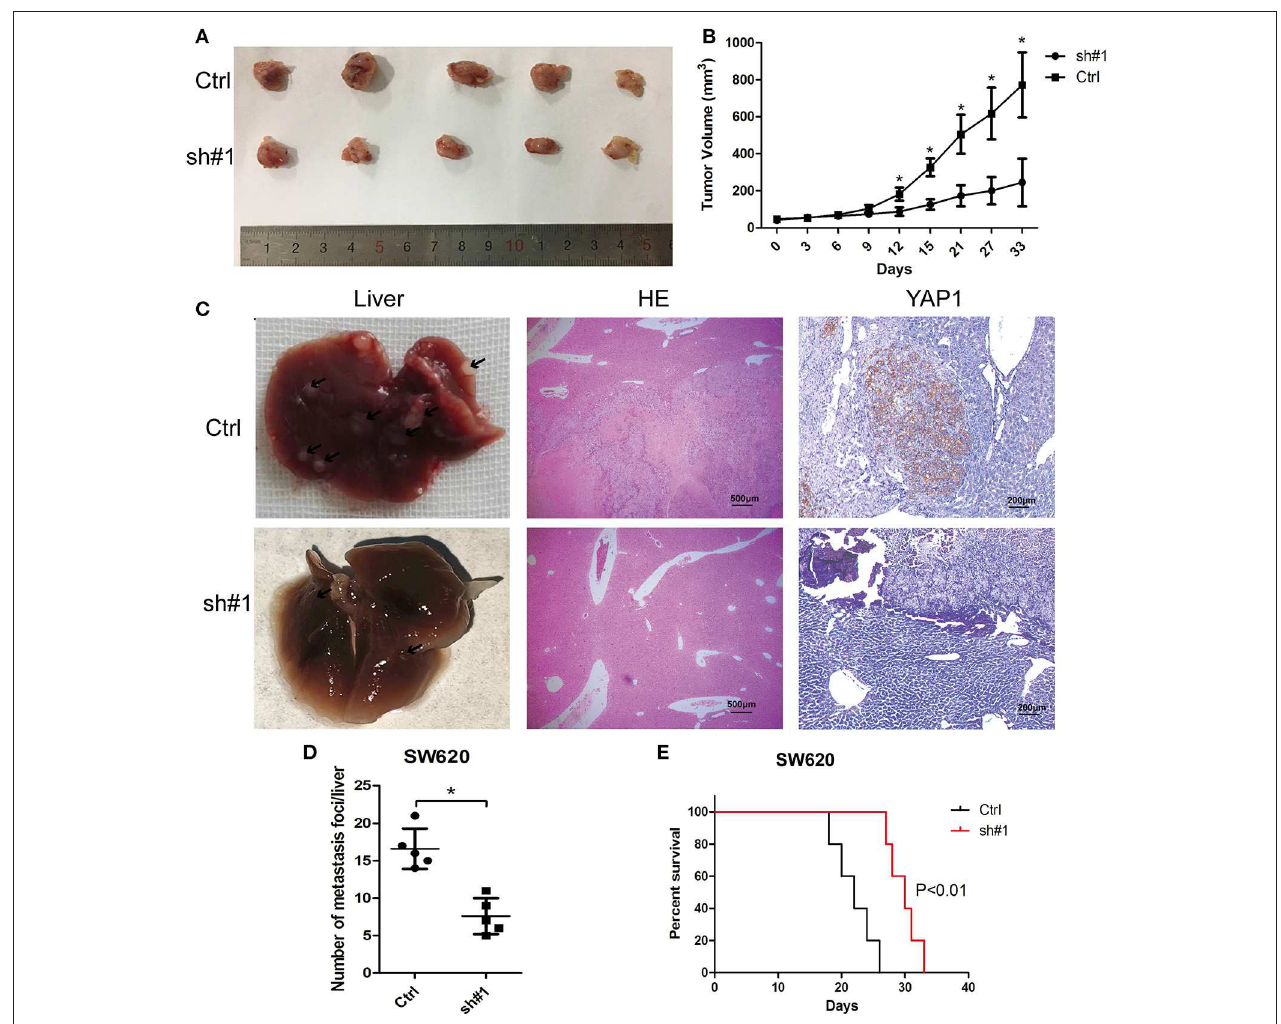
FIGURE 4 | MIR4435-2HG silencing inhibited colorectal cancer (CRC) growth and metastasis in vivo . (A,B) SW620 cells where MIR4435-2HG was stably knocked down of were subcutaneously transplanted into BALB/c nude mice in a xenograft model ( n = 5 mice per group). Two-tailed Student’s t -test. Tumor volumes were monitored at the suggested time points in the control (Ctrl) and experimental (sh#1) groups. (C) Representative livers from the orthotopic mouse model of CRC, hematoxylin and eosin-stained images and immunohistochemical stained images of YAP1 show metastatic lesions and the YAP1 expression in the livers. (D) Mean ± SD. * P < 0.05 denotes the number of metastatic nodules in the livers; using two-tailed Student’s t -test; n = 5. (E) Overall survival curve of mice from the orthotopic model of CRC according to the MIR4435-2HG expression ( n =